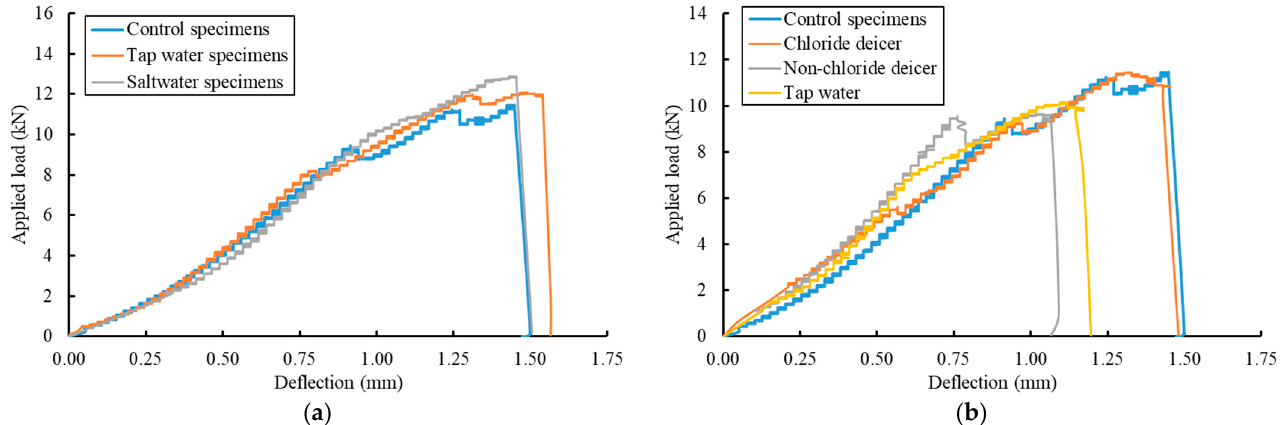
Figure 15. Load deflection response comparisons of the three-point bending test results. ( a ) Wet- and-dry cycles. ( b ) Freeze-and-thaw cycles.